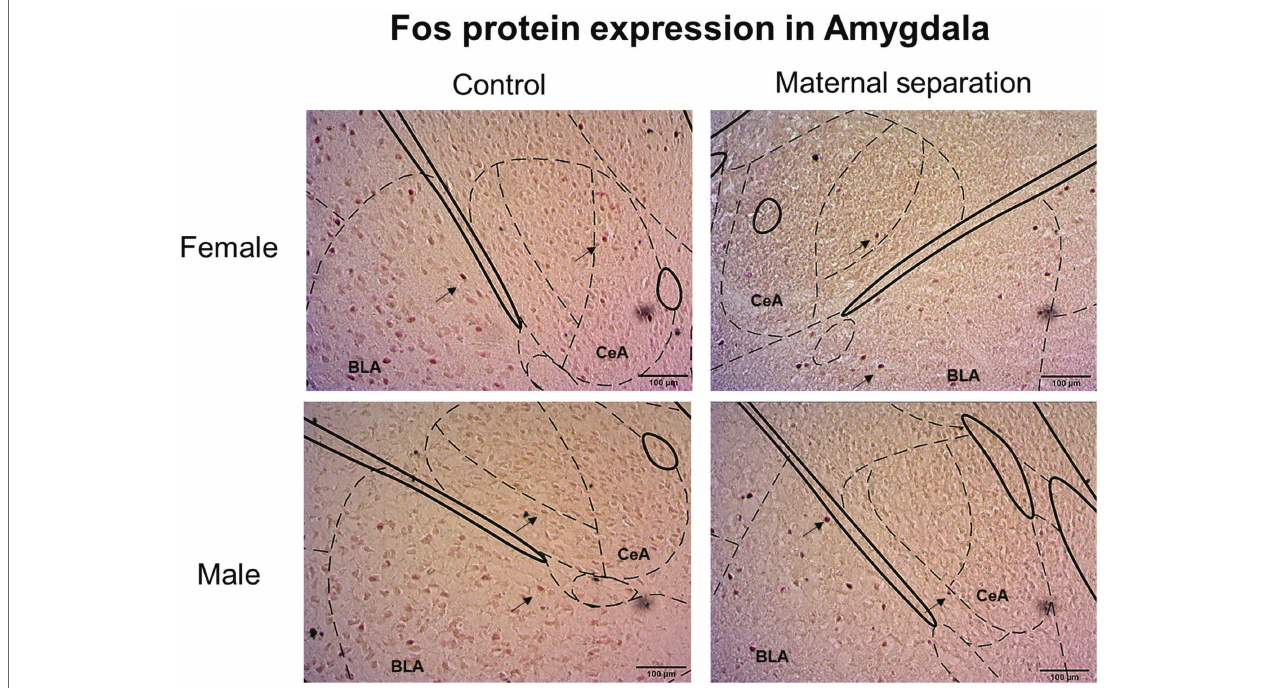
FIGURE 8 | Fos protein expression in BLA and CeA. Images represent Fos positive cells in BLA and CeA of female and male mice submitted to MS and control group. Black arrows indicate Fos-IR neurons. Coordinates for amygdala (AMY): 1.82 mm posterior to bregma (Paxinos and Franklin,